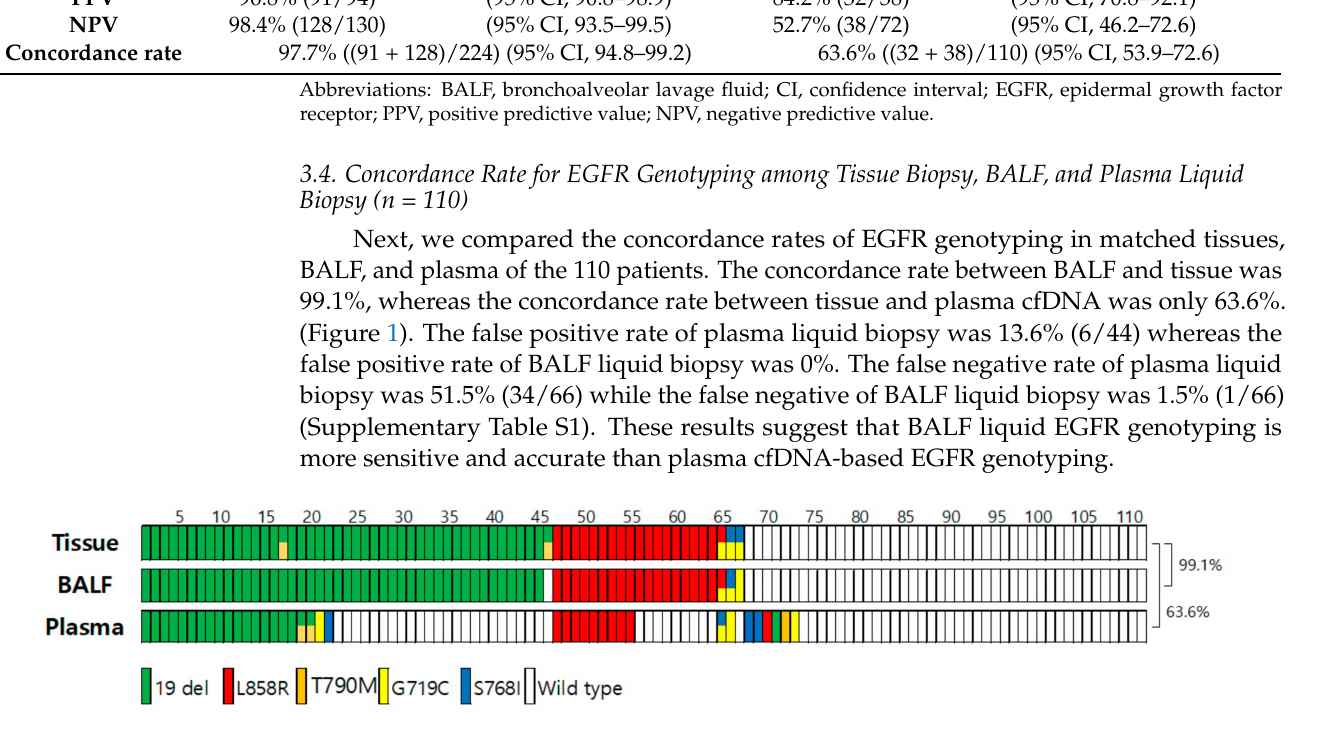
Figure 1. Concordance rate for EGFR genotyping among tissue biopsy, BALF liquid and plasma liquid biopsy ( n = 110) (double colors mean double EGFR